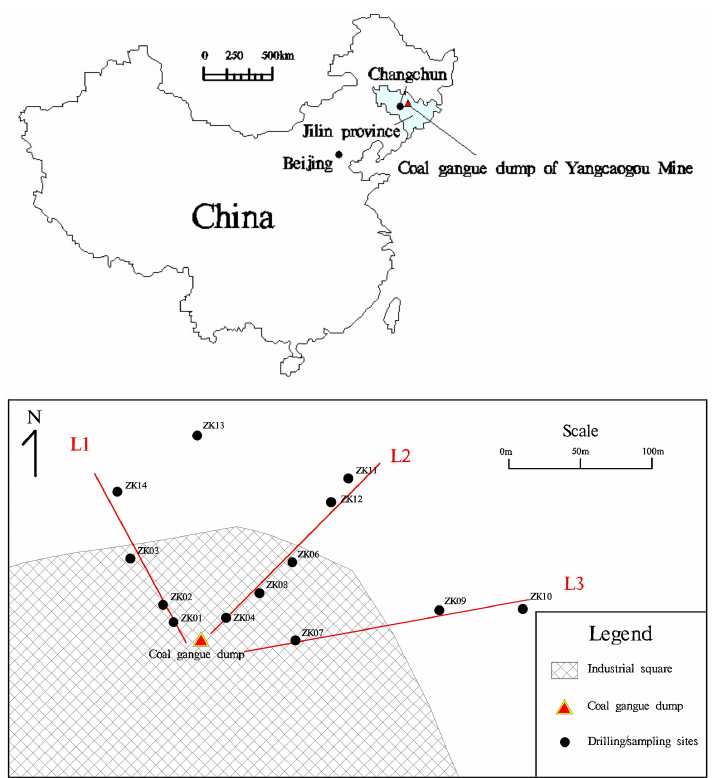
Figure 1. Location of Yangcaogou Mine and soil sampling points around the coal gangue dump (the red lines represent sampling